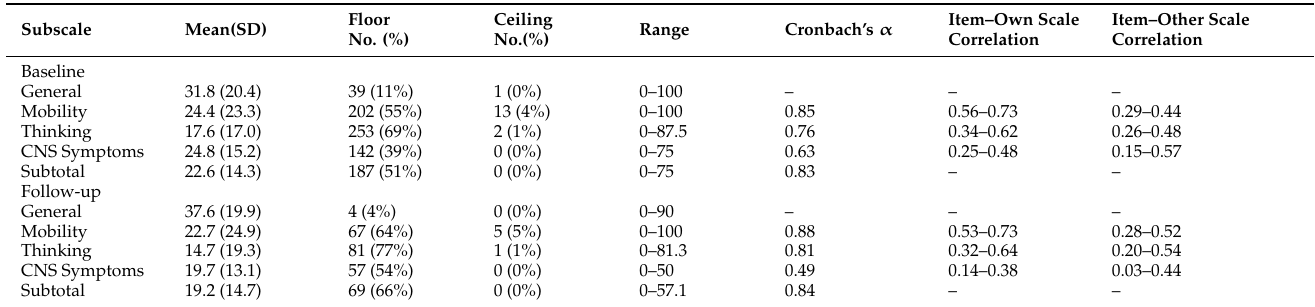
Table 3. Summary